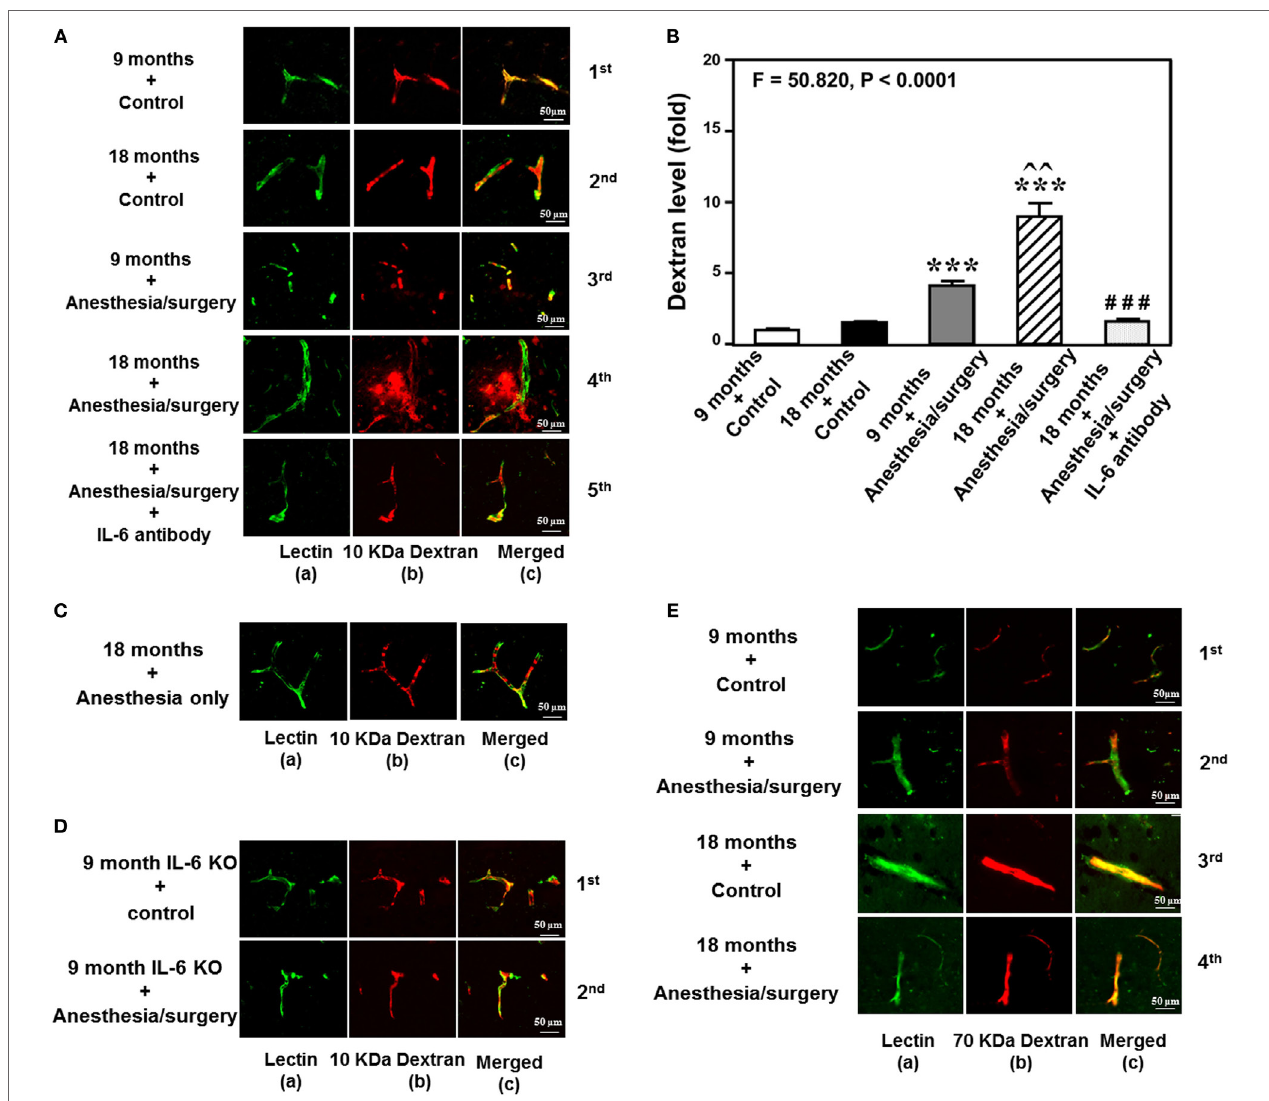
FigUre 2 | Anesthesia/surgery increases blood–brain barrier permeability of dextran in mice in an age-associated manner. (a) Immunostaining of blood vessels (lectin, green, column a ) and dextran (10-kDa dextran, red, column b ) of the brain section following the control condition in 9-month-old mice (the first row), the control condition in 18-month-old mice (the second row), the anesthesia/surgery in 9-month-old mice (the third row), the anesthesia/surgery in 18-month-old mice (the fourth row), and the anesthesia/surgery in 18-month-old mice pre-treated with IL-6 antibody (the fifth row). Column c is the merged image of columns a and b . The red spots (non-overlap area) in column c indicate the dextran that is not inside the blood vessel (extravascular dextran). N = total of 90 slides from 3 mice in each group. (B) Quantification of the immunostaining images shows that the anesthesia/surgery in 9-month-old mice (gray bar) increases the extravascular dextran level in the mouse brain tissues as compared to that in the control condition in 9-month-old mice (white bar). The anesthesia/surgery in 18-month-old mice (net bar) increases extravascular dextran level in the mouse brain as compared to that in the control condition in 18-month-old mice (black bar) and that in anesthesia/surgery condition in 9-month-old-mice (gray bar). Treatment with IL-6 antibody (dot bar) attenuates the anesthesia/surgery-induced increase in the extravascular dextran level in the brain tissues of 18-month-old mice (net bar). (c) Immunostaining of blood vessels (lectin, green, column a ) and dextran (10-kDa dextran, red, column b ) of the brain section following anesthesia only in one 18-month-old mouse. Column c is the merged image of columns a and b . Anesthesia only does not increase the extravascular dextran level in the brain tissues of the 18-month-old mouse. The image represents one mouse. The studies were repeated twice in another two mice. (D) Immunostaining of blood vessels (lectin, green, column a ) and dextran (10-kDa dextran, red, column b ) of the brain section following anesthesia/surgery in one 9-month-old IL-6 gene knockout mouse. Column c is the merged image of columns a and b . The red spots (non-overlap area) in column c indicate the dextran that is not inside the blood vessel (extravascular dextran). Anesthesia/surgery does not significantly increase the extravascular dextran level in the brain tissues of the 9-month-old IL-6 gene knockout mouse. The study was repeated in another mouse. (e) Immunostaining of blood vessels (lectin, green color, column a ) and 70-kDa dextran (red, column b ) of the brain section following the control condition in 9-month-old mice (the first row), the anesthesia/surgery in 9-month-old mice (the second row), the control condition in 18-month-old mice (the third row), and the anesthesia/surgery in 18-month-old mice (the fourth row). Column c is the merged image of columns a and b . The red spots (non-overlap area) in column c indicate the 70-kDa dextran that is not inside the blood vessel (extravascular dextran). The anesthesia/surgery does not significantly increase the extravascular 70-kDa dextran level in the brain tissues of the 9-month-old mouse and 18-month-old mouse as compared to control condition. The image represents one mouse. The studies were repeated in another two mice. IL,